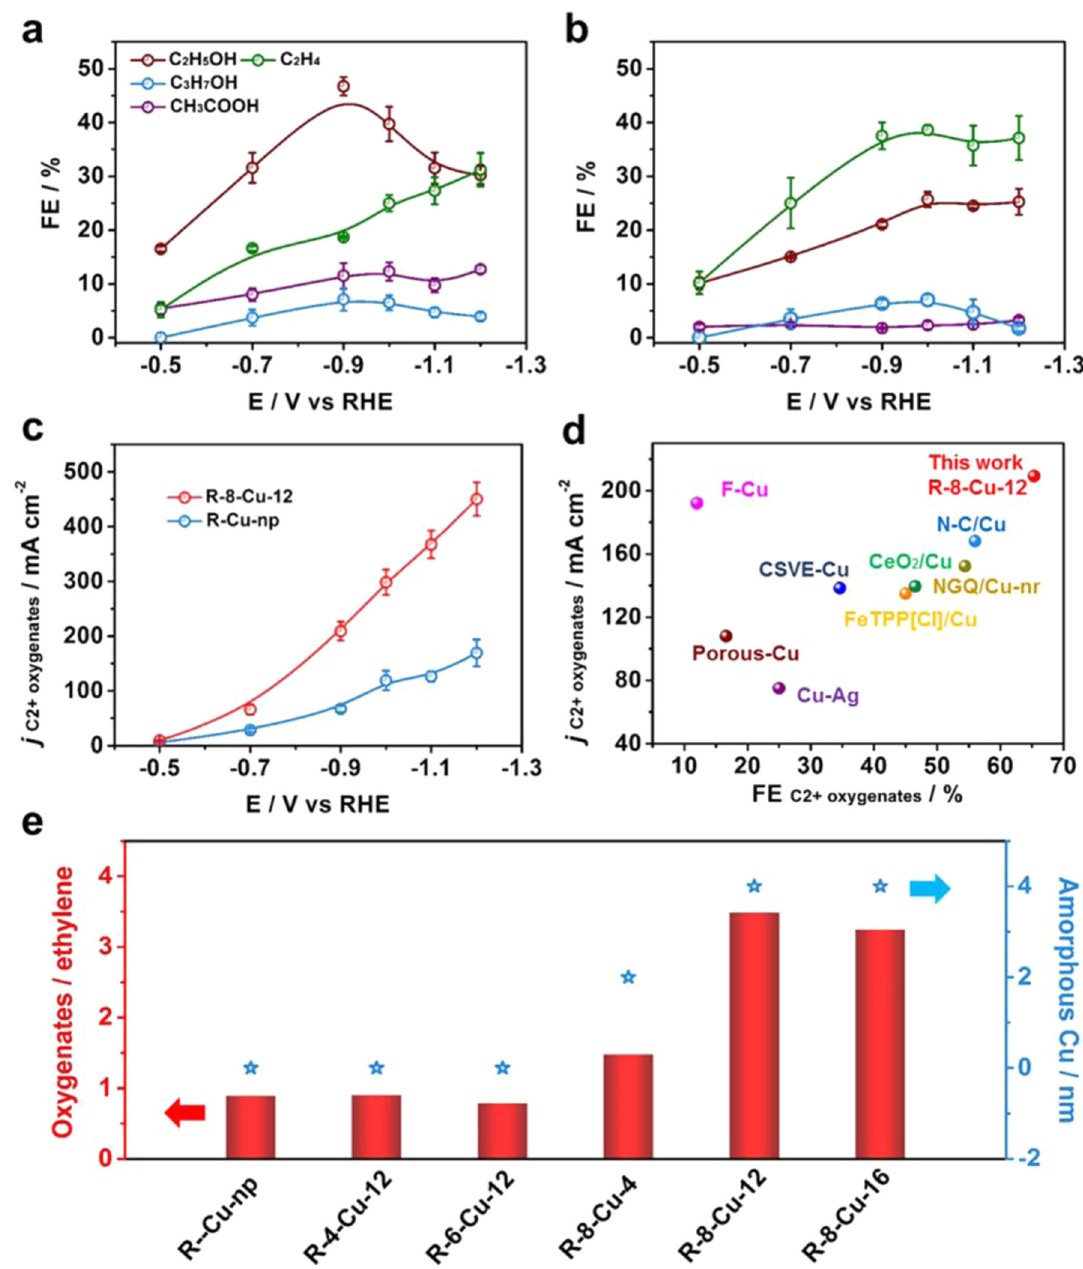
Fig. 3 | CO 2 RR performance for R-8-Cu-12 and R-Cu-np. a The distribution of C2+products at different potentials over R-8-Cu-12. b The distribution of C2+ products at different potentials over R-Cu-np. c The partial current density of C2+ oxygenates at different potentials for R-8-Cu-12 and R-Cu-np. d Plot of C2+ oxy- genates partial current density versus maximum C2+ oxygenates FE for various